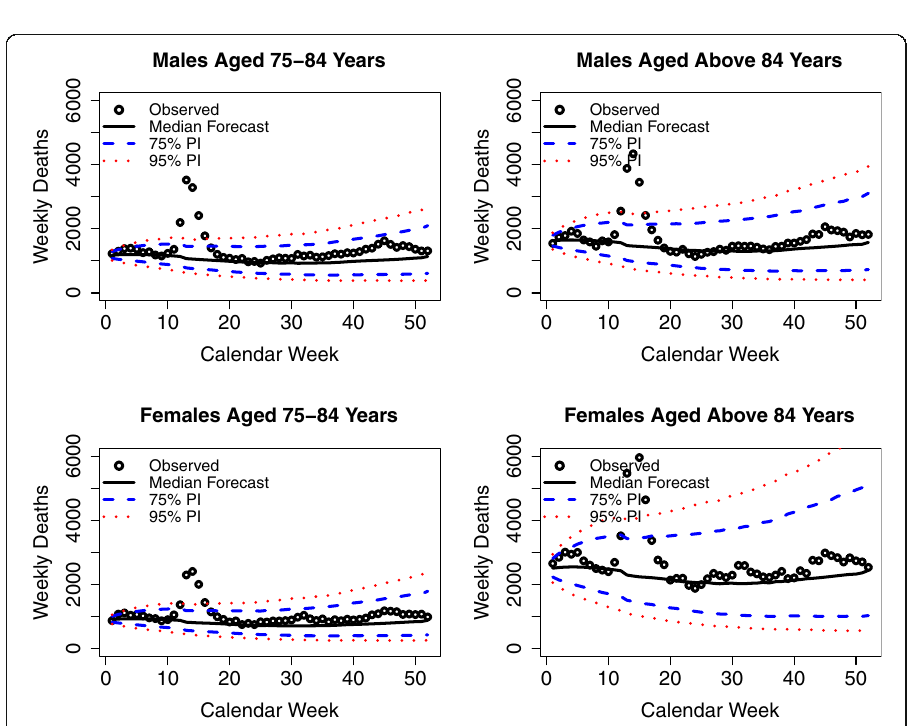
Fig. 17 Observed and predicted weekly death numbers in 2020 in Spain by sex and age above 74 years of age. Sources: Human Mortality Database (2021); Computations and design by the